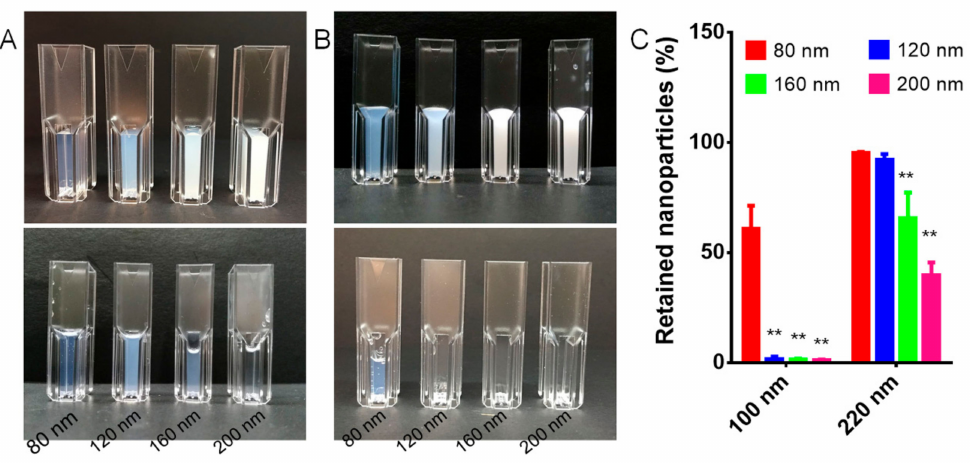
Figure 4. Photo images di ff erent-sized RBC-NPs before (upper row) and after (lower row) passing through ( A ) 0.22 µ m or ( B ) 0.1 µ m syringe filters. ( C ) The relative retention of RBC-NPs in the filtrate after passing through 0.22 µ m or 0.1 µ m syringe filters. ** p < 0.01 compared with 80 nm